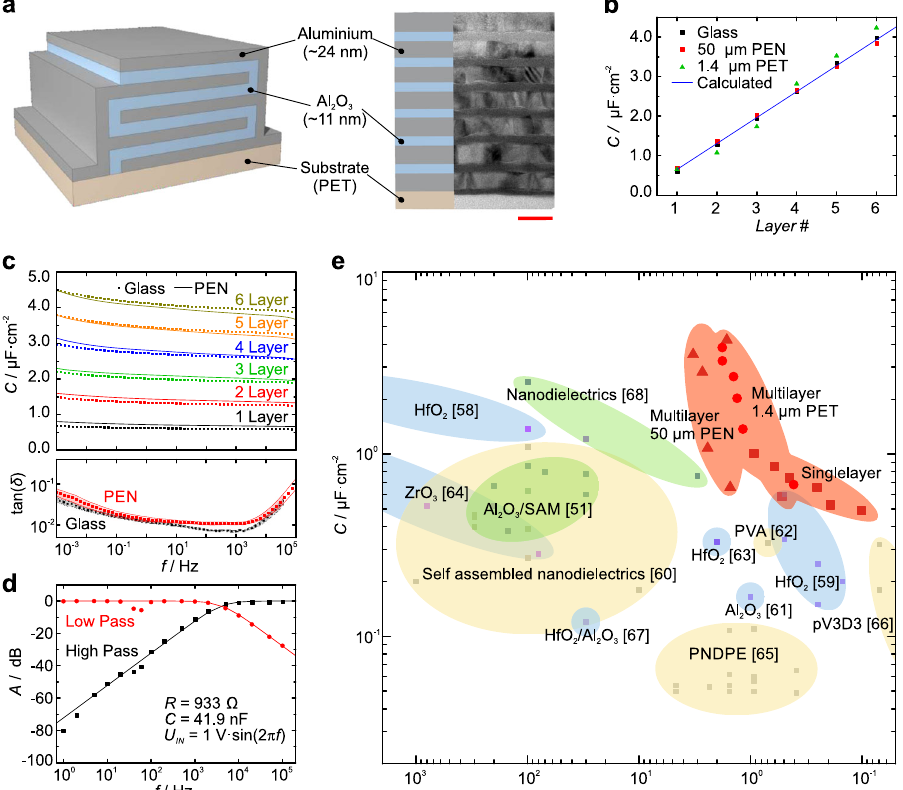
Fig. 3 Multilayer capacitors fabricated by local anodisation. a Schematic of multilayer structure and corresponding STEM image, highlighting the high precision and reproducibility of the anodisation process down to nm-size. Scale bar: 50 nm b Each layer increases the capacitance linearly until a value of 4.2 µF cm − 2 is achieved for six layers. No signi fi cant in fl uence of the substrate (50 µm PEN, 1.4 µm PET, and borosilicate glass) is observed. The increase matches well with theoretical predictions (solid blue line) were an oxide thickness of 12 nm and a dielectric constant of ε r = 9 is assumed (see SI for details). This leads to an increase of 650 nF cm − 2 per layer. c Impedance data show a linear increase in capacitance and the same shape for all number of layers. The dielectric loss tangent is independent on the number of layers. Dotted lines are for samples prepared on glass, solid lines represent fl exible devices on PEN. d High and low pass fi lters from anodically printed resistors and multilayer capacitor structures. Here, a resistor of 933 Ω and a capacitance of 41.9 nF is used. Measurements (black and red points) agree excellently with simulation (solid lines, see SI for details). e Comparison of capacitance per area and leakage current density with literature. 51,58-68 Our multilayer capacitors (red symbols) reach record-high capacitance of 4.2 µF cm − 2 at sub-10 nA cm − 2 leakage current